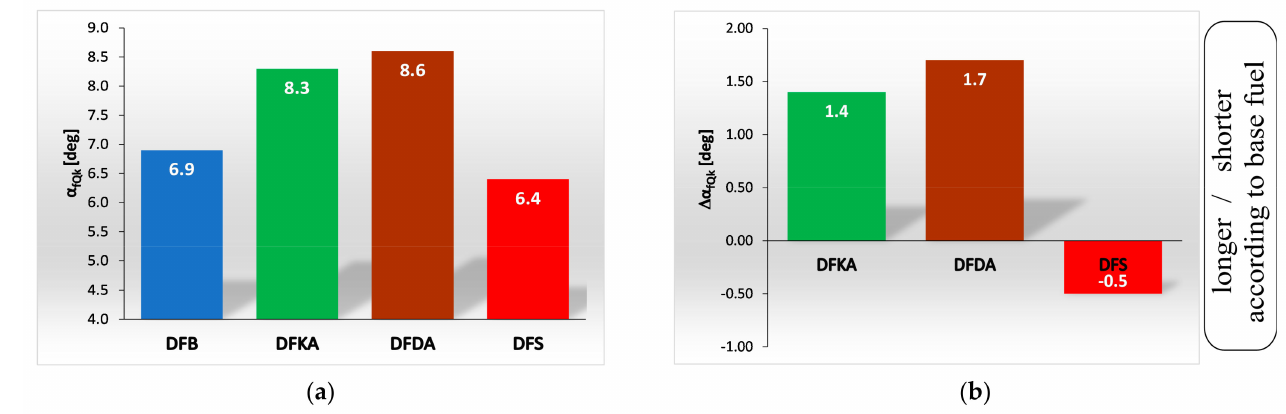
Figure 22. ( a ) Duration of kinetic phase ( α fQk ) for tested fuels. ( b ) Percent change ( ∆ α fQk ) for tested fuels relative to α fQk for DFB (base fuel).